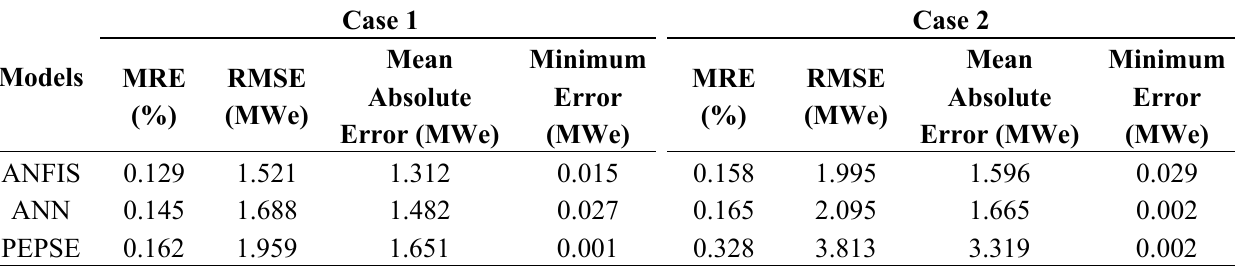
Table 2. Statistical parameters for different